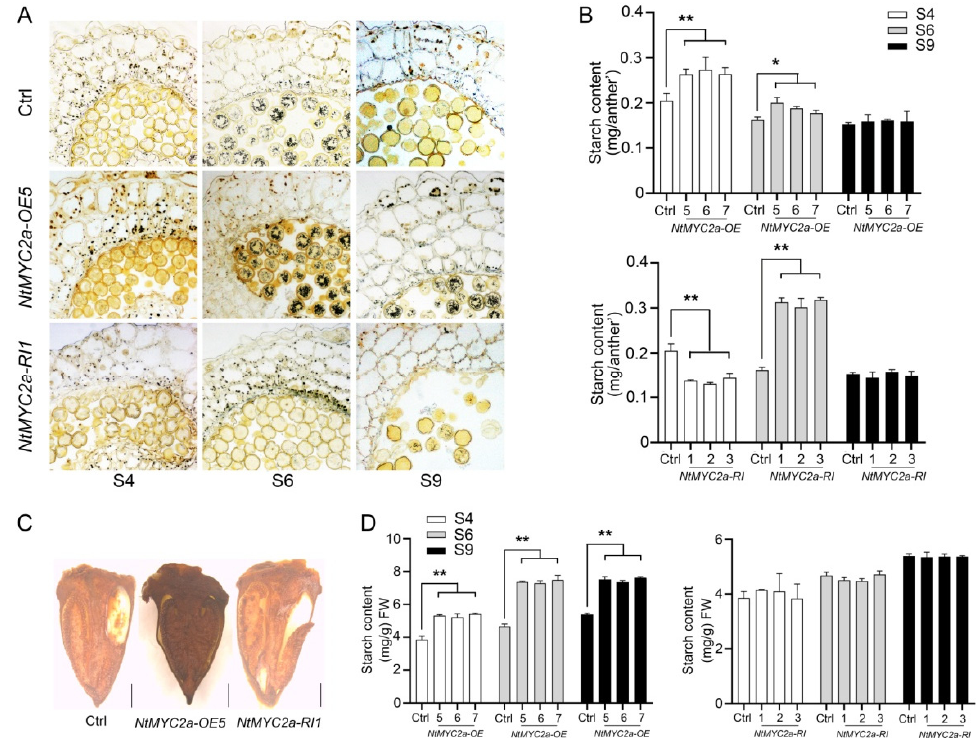
Figure 3. Total analysis of starch content in anther wall and ovary at indicated floral development stages. ( A ) I 2 /KI staining of the anther sections of NtMYC2a -OE/RI and control plants at S4–S9; ( B ) Analyses of starch content in anther wall of NtMYC2a -OE/RI and control plants at indicated floral development stages. Data are shown as means ± SD, n = 10. * p < 0.05, ** p < 0.01 (Student’s t -test); ( C ) I 2 /KI staining of the ovaries of NtMYC2a -OE/RI and control plants at S9. Bar = 1 mm; ( D ) Analyses of starch content in ovary of NtMYC2a -OE/RI and control plants at indicated floral development stages. Results are shown as means ± SD, n = 3. Significant differences from the data of control plants are indicated: * p < 0.05, ** p < 0.01 (Student’s t -test).